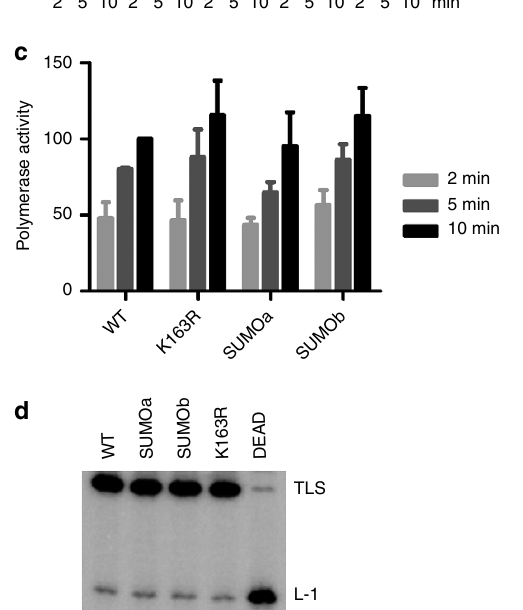
Figure 3 | K163R and SUMO pol g retain full catalytic activity in vitro . ( a ) Schematic representations of the pol Z mutants used in the study. In addition to WTand K163R pol Z , a constitutively SUMOylated pol Z (SUMO) was constructed by inserting the sequence of SUMO2 in place of K163. A track of 7 glycines (G) was added before SUMO2 to confer flexibility. The C-terminal di-G motif of SUMO2 was mutated to alanines to prevent cleavage by the SENPs. Two constructs were generated: SUMOa contains the atg of SUMO2, whereas it was mutated to G in SUMOb. A catalytically inactive pol Z (polDEAD) was used as a negative control. ( b ) The indicated proteins were produced in rabbit reticulocytes and their catalytic activity was analysed by primer extension on a circular single-stranded undamaged template (representative gel). ( c ) Polymerase activity is shown as a percentage of the activity measured for WT pol Z in 10-min reaction (mean ± s.d. of three independent experiments). ( d ) For analysis of TLS efficiency, equal amounts of the in vitro translated proteins were introduced in an XPV cell extract. Bypass of a single TT-CPD (TLS) was assessed as described in Methods. L-1: fragment elongated up to one nucleotide before the